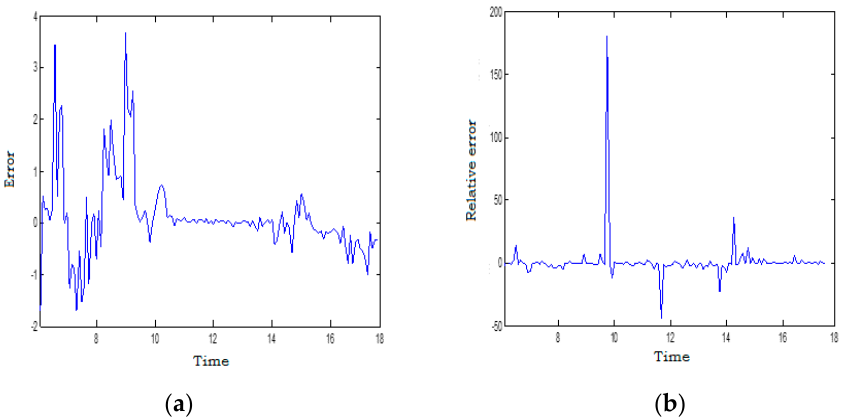
Figure 4. Differentiated and predicted solar radiation using ARMA (3,3) for a winter day. To assess the performances of the ARMA (3,3) model, error and relative error are calculated and presented in Figure 5. In addition, Mean Square Error (MSE), Mean Absolute Error (MAE), and Root Mean Square Error (RMSE) are estimated and presented in Table 2.